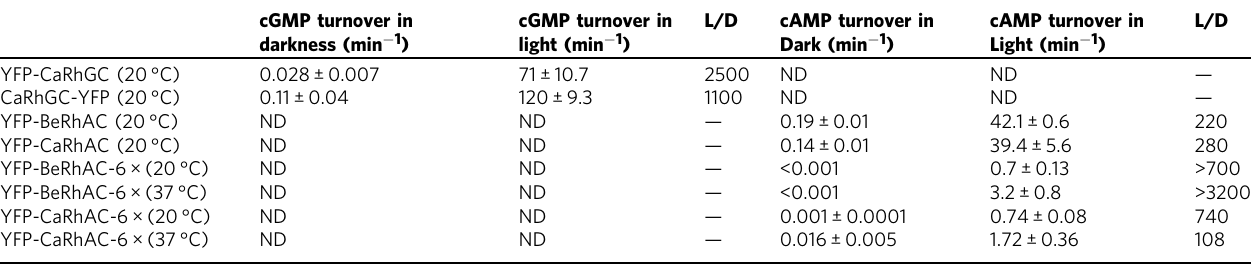
Table 2 In vitro production of cAMP and cGMP by RhACs in oocyte membranes